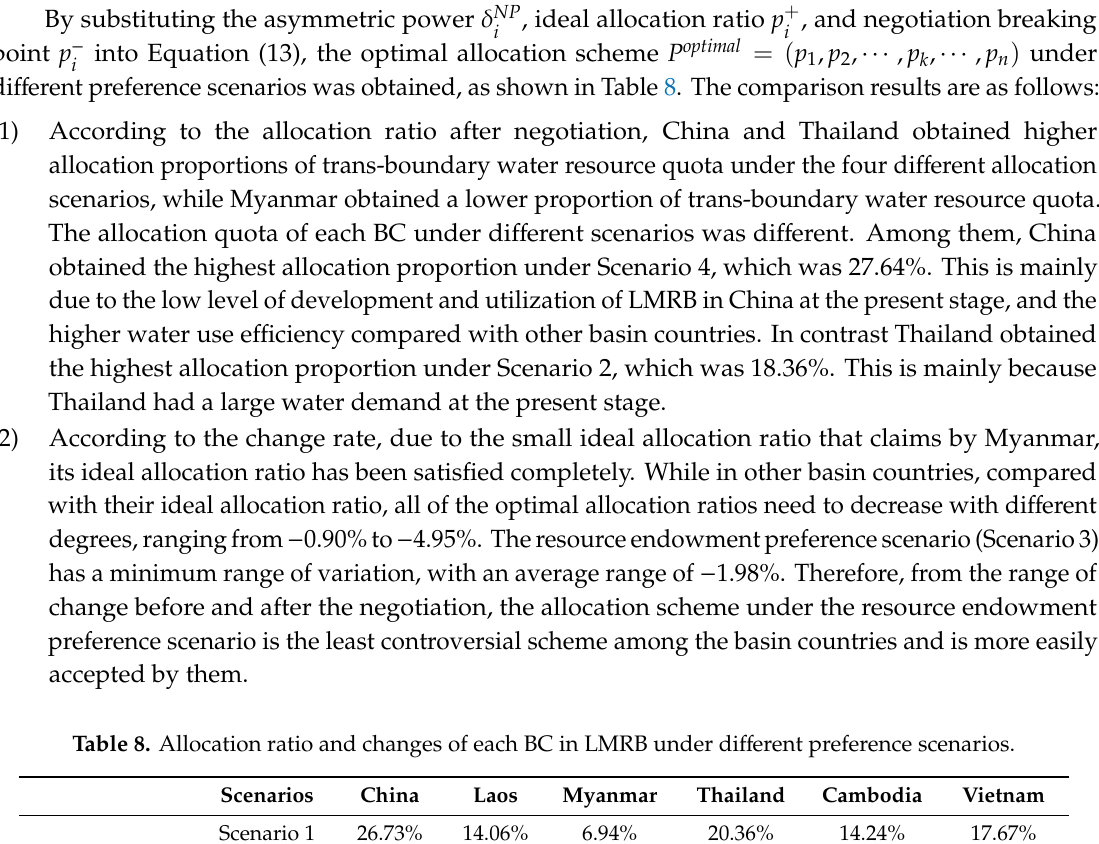
Table 8. Allocation ratio and changes of each BC in LMRB under di ff erent preference scenarios. Scenarios China Laos Myanmar Thailand Cambodia Vietnam Allocation ratio